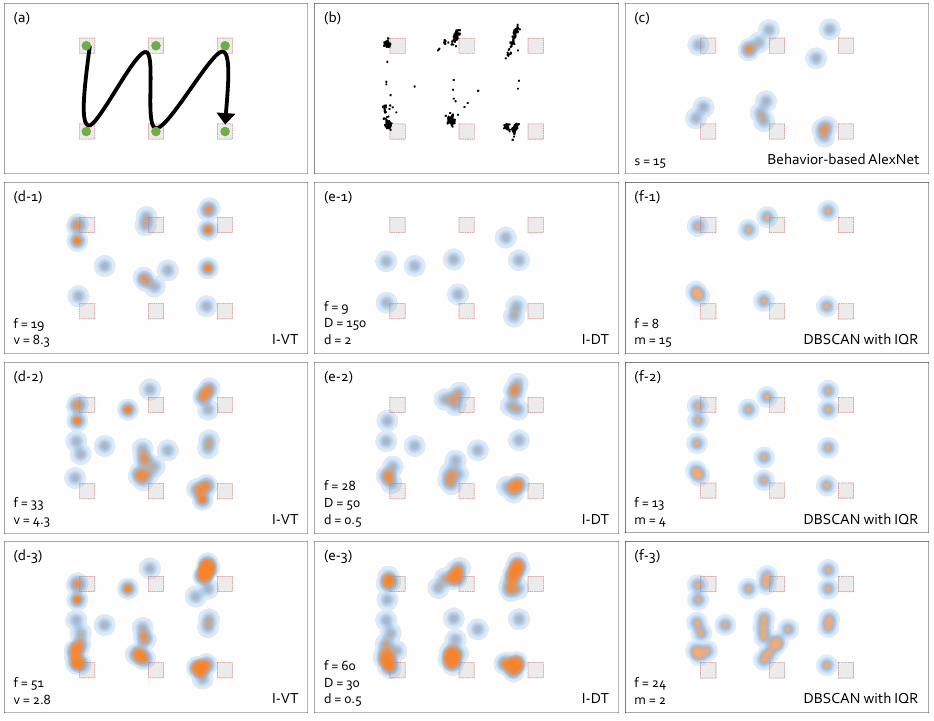
Figure 9. Comparison of heatmaps with different gaze-parsing algorithms. ( a ) A visual stimulus, including the eye movement task of an observer. The observer paused for 3 s at the point where the green dots are drawn during the eye movement. ( b ) The raw gaze points. ( c ) The heatmap with the behavior-based gaze data processing method using AlexNet. The heatmap with I-VT in ( d-1 – d-3 ), I-DT in ( e-1 – e-3 ), and DBSCAN with IQR in ( f-1 – f-3 ) are